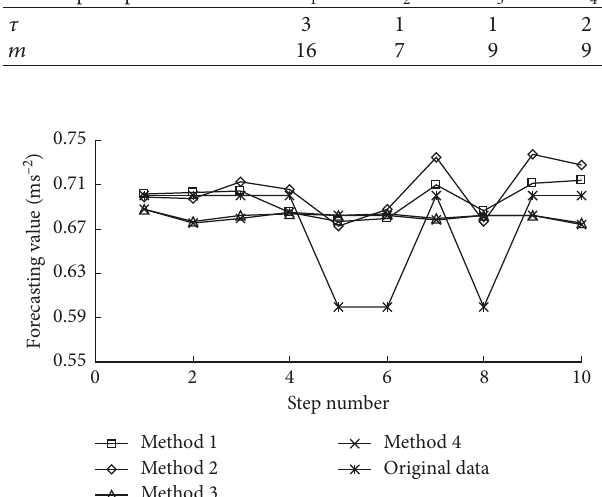
Figure 2: Chaotic prediction results for subseries X